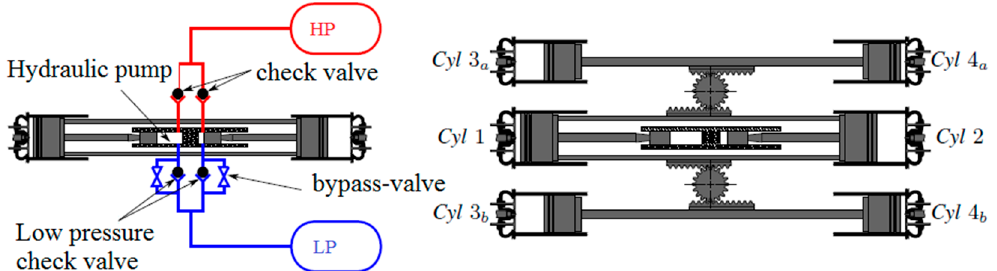
Figure 15. One kind of dual-piston HFPE [38].